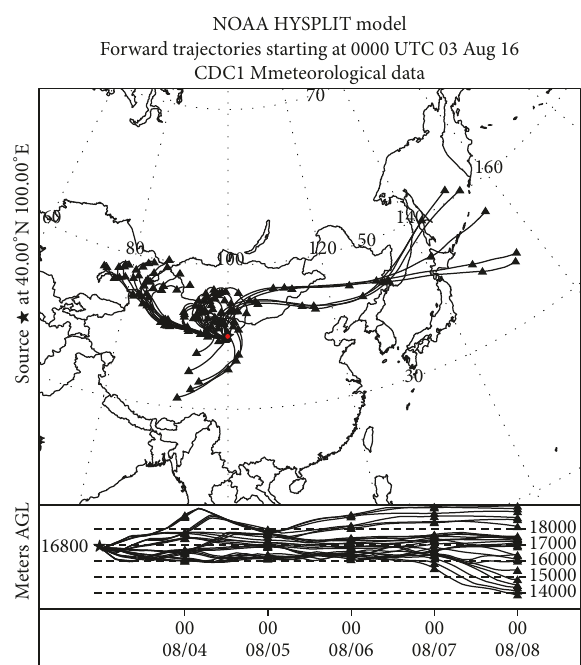
Figure 9: The ensemble forward trajectories at 16.8 km on Aug 3, 2016. The top part shows the time evolution of trajectories in the horizontal and the bottom part which indicates the vertical variation of trajectories with time. The trajectory released at 40 ∘ N, 100 ∘ E (red dot). The duration is 120 hours.